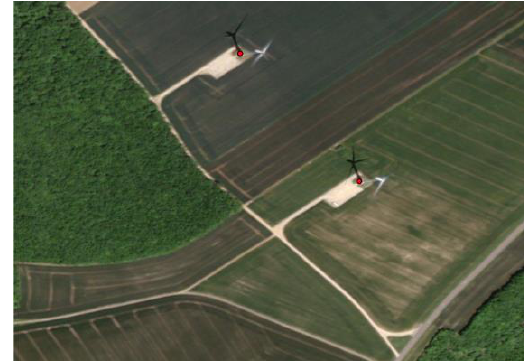
Figure 5 . OSM windmills point overlaid on a Geoportail image.